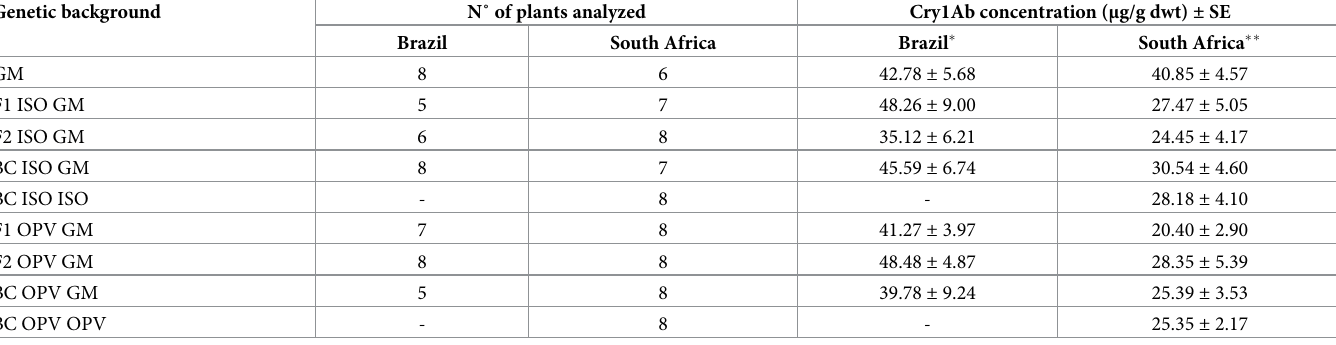
Table 3. Number of maize plants analyzed, mean and standard error ( ± SE) of the Cry1Ab concentration in the different genetic backgrounds from Brazil and South Africa. Genetic background